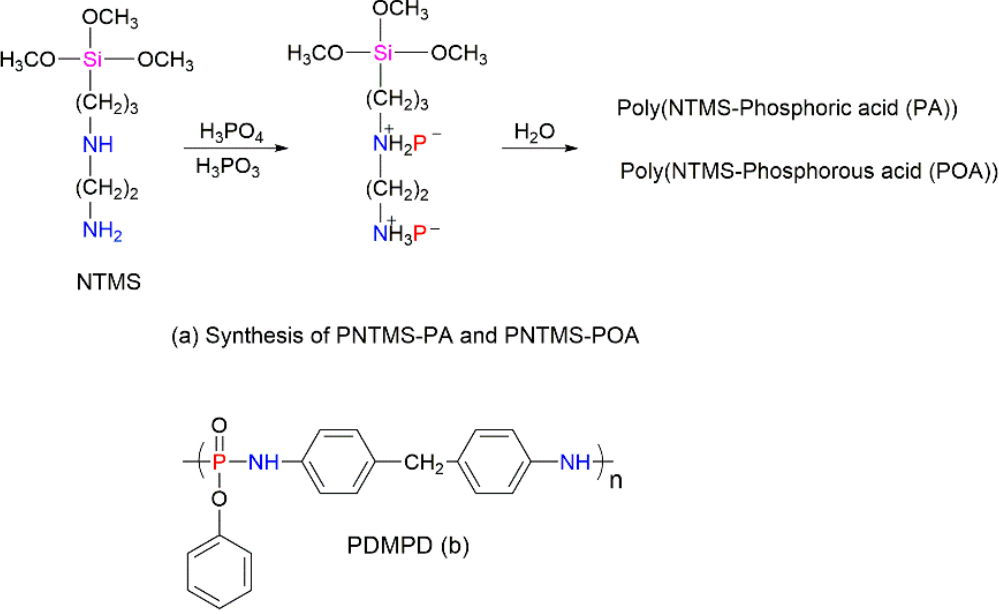
Figure 16. Synthesis of PNMTS-PA and PNTMS-POA (a) and the chemical structure of PDMPD (b) [95,97]. NMTS: N - β -(aminoethyl)- γ -aminopropyltrimethoxysilane, PA: phosphoric acid, H 3 PO 4 , POA: phosphorus acid, H 3 PO 3 , PDMPD: poly(4,4 ′ -diaminodiphenylmethanephenyldichlorophosphate).